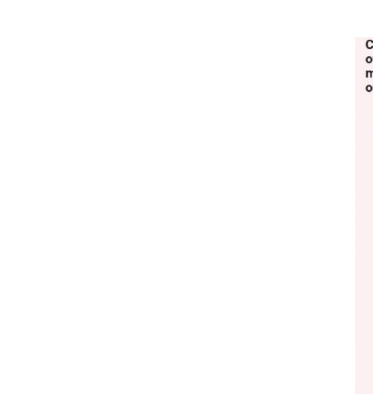
FIGURE 4 | Exosomes as a therapeutic carrier. There are two strategies to load exosomes with therapeutic cargo, like RNA species for gene silencing in targeted cancer cells or small molecule compounds of concern: (1) endogenously, by collecting exosomes from cells overexpressing the molecule of interest, or (2) exogenously, by collecting exosomes from an appropriate cell culture that produces exosomes suitable for speci fi c targeting and then incubating or electroporating the exosomes with the molecule of interest. (3) Once the exosomes are successfully loaded, (4) exosomes can be used for their respective therapeutic applications (BioRender.com was used to create this fi